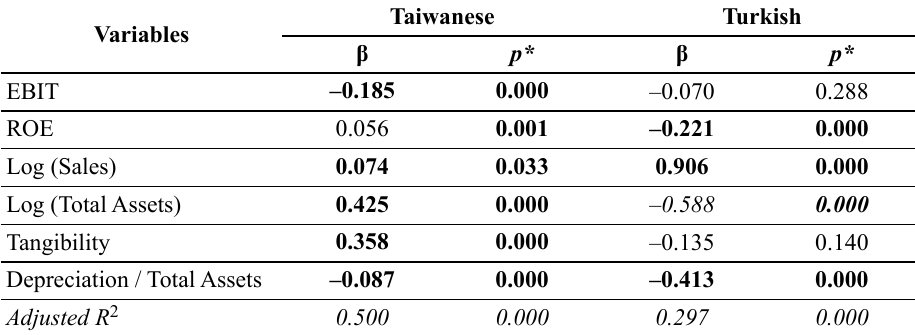
Table 4. Effects on the Long-term Debts / Total Assets ratio (LD / TA) Variables